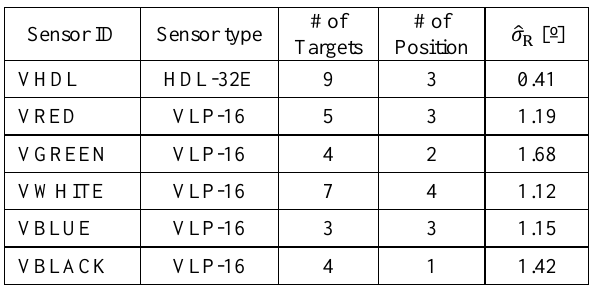
Table 2. Results of the LiDAR orientation